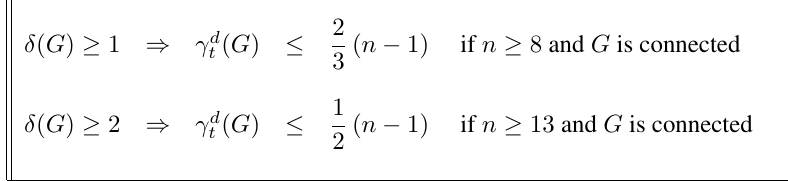
Table 2: Upper bounds on the disjunctive total domination number of a graph G